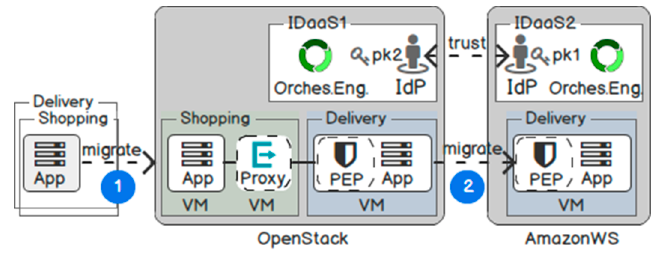
Figure 7. Test environment.